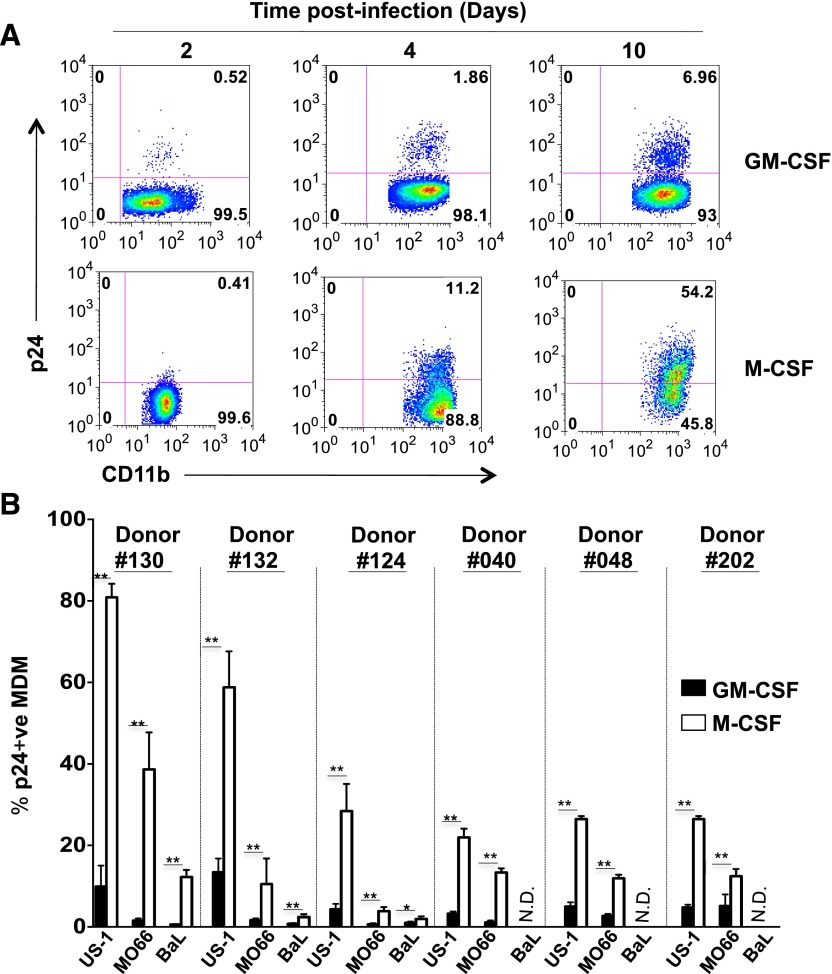
GM-CSF–derived MDM are less permissive to HIV-1 infection than M-CSF–derived MDMs.(A). Primary human monocytes were differentiated into MDMs following in vitro culture in GM-CSF or M-CSF media for 5 d and infected with US-1 (5 ng p24). Cells were harvested and analyzed for the presence of intracellular p24 by flow cytometry. Panels show dot plots of US-1–infected GM-CSF– or M-CSF–derived MDMs at 2, 4, and 10 d postinfection. A representative of 3 independent experiments is shown. (B). HIV-1 infectivity of GM-CSF– and M-CSF–derived MDMs was evaluated in 6 seronegative donors following infection with 3 primary HIV-1 subtypes (5 ng p24). Cells were analyzed on day 4 postinfection for the presence of intracellular p24 by flow cytometry. Bar graph shows the percentage (means ± sd) of infected GM-CSF– and M-CSF–derived MDMs (filled bars and open bars, respectively). Data are representative of 3 independent experiments done in triplicate. Sample sets were compared using the Mann-Whitney test (*P = 0.01; **P = 0.002).